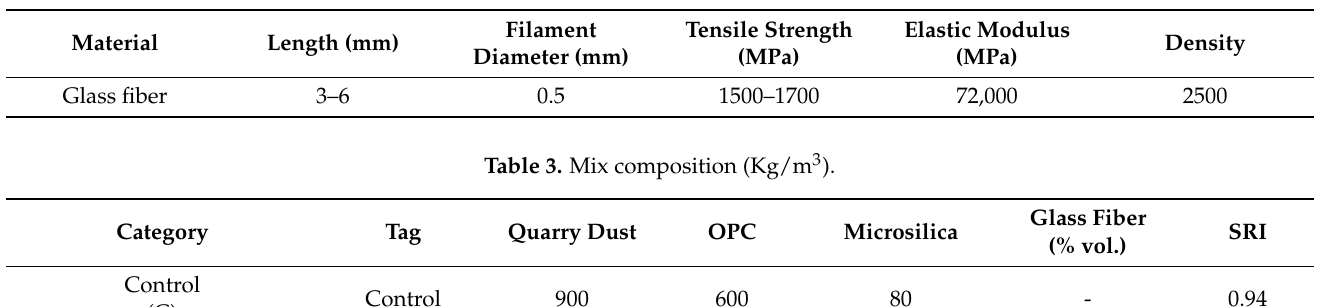
Table 2. Physical properties of glass fiber.